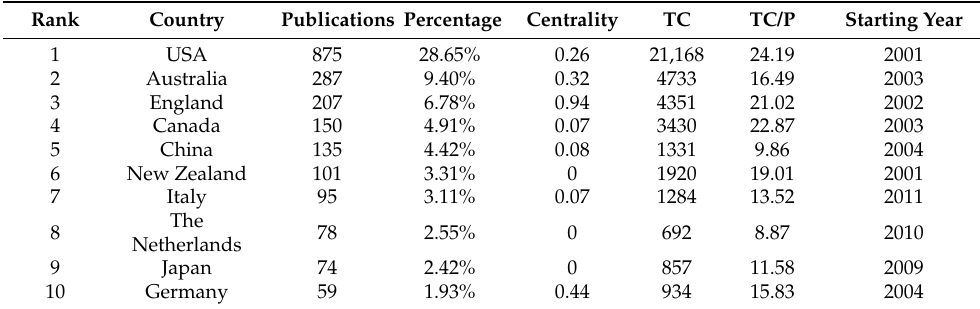
Table 1. Top 10 countries/regions according to publications. Note that TC and TC/P represent the total citations and the average of citations per paper for a country, respectively.